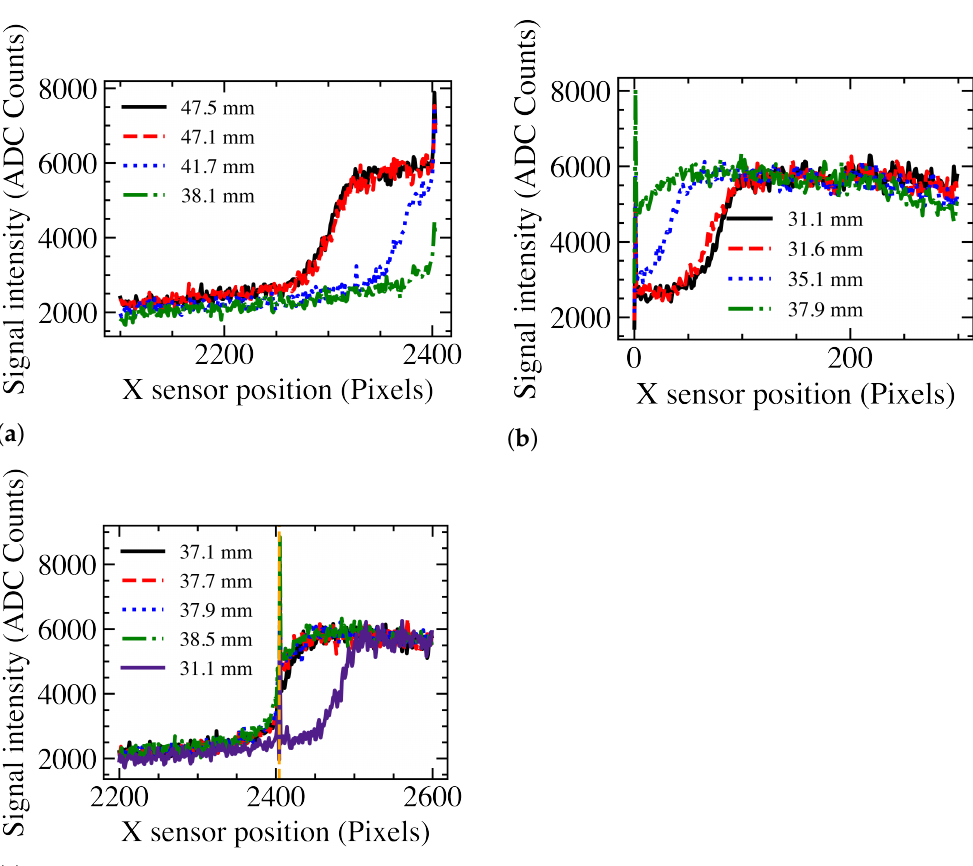
Figure 3. Projection of an MLC leaf edge in one set of 5 averaged frames for a leaf moving from Lassena 2 to Lassena 1 at various leaf extensions. Signal for Lassena 2 in ( a ). Signal for Lassena 1 in ( b ). The legend gives the leaf extensions. ( c ) shows the signal on both Lassenas for several leaf extensions. The black dotted line shows that transition and dead area between the